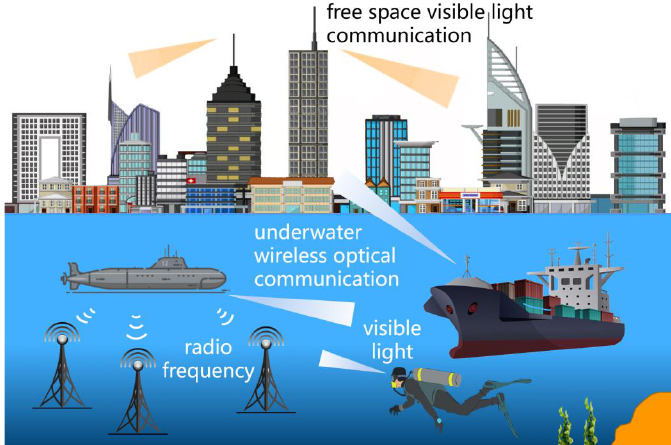
Figure 5. OIL in different VLC